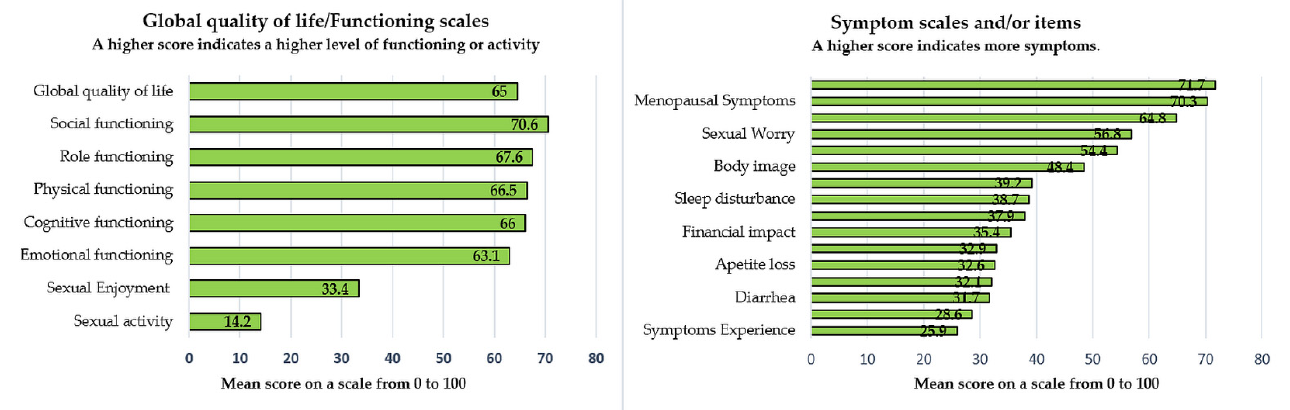
Figure 2. The QoL of the 208 patients who answered the EORTC QLQ-C30 and EORTC